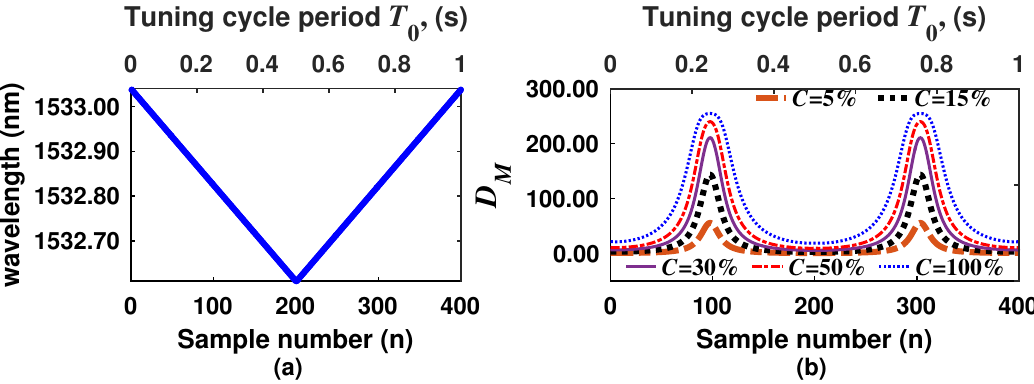
Figure 3. ( a ) Laser wavelength as a function of time; ( b ) depth of modulation as a function of time, considering different concentrations of C 2 H 2 and l = 10 cm.